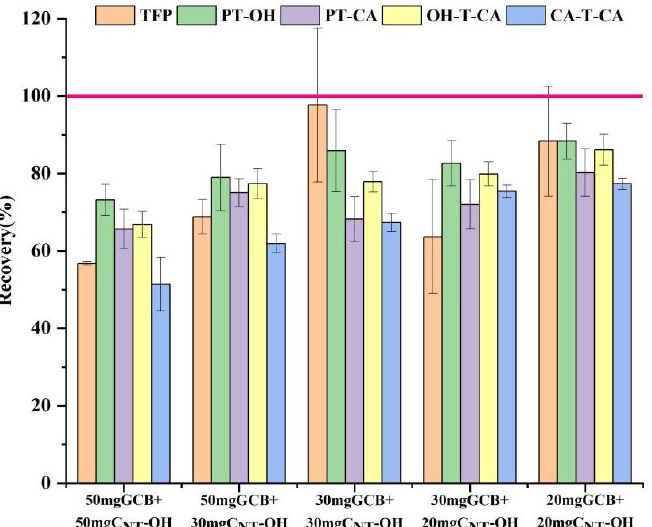
Figure 2. The recoveries of TFP and its metabolites under different dosage combinations of GCB and C NT -OH (the red horizen line represents the recovery of 100%, and the closer to it, the higher the accuracy).